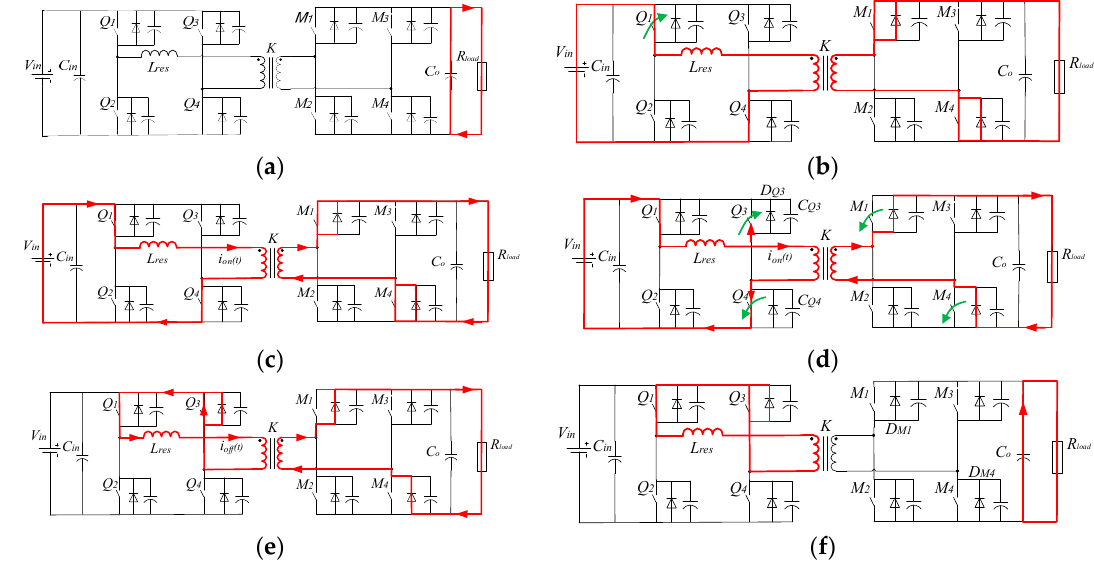
Figure 3. Power flow of operation: ( a ) Mode 1—Dead time; ( b ) Mode 2—ZCS; ( c ) Mode 3—Power transferring; ( d ) Mode 4—ZVS; ( e ) Mode 5—Freewheeling; ( f ) Mode 6—Nil.